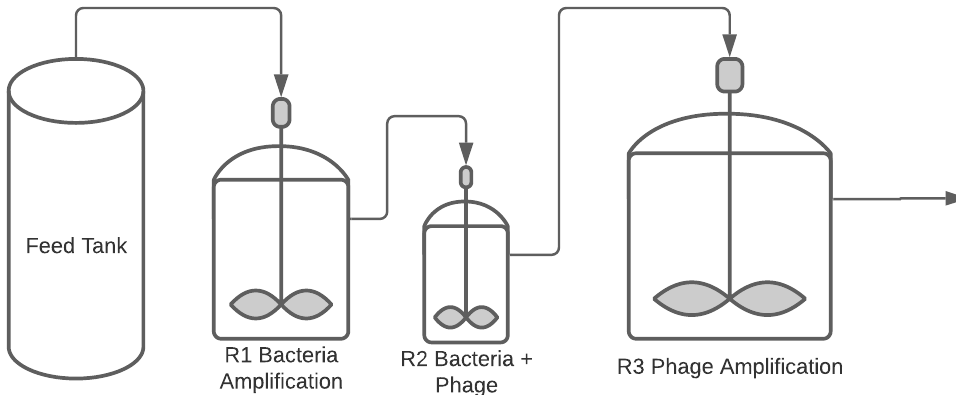
Figure 3. A simplified PFD of a continuous phage manufacturing system. As before, all the control systems are excluded to provide a simple depiction of the system.